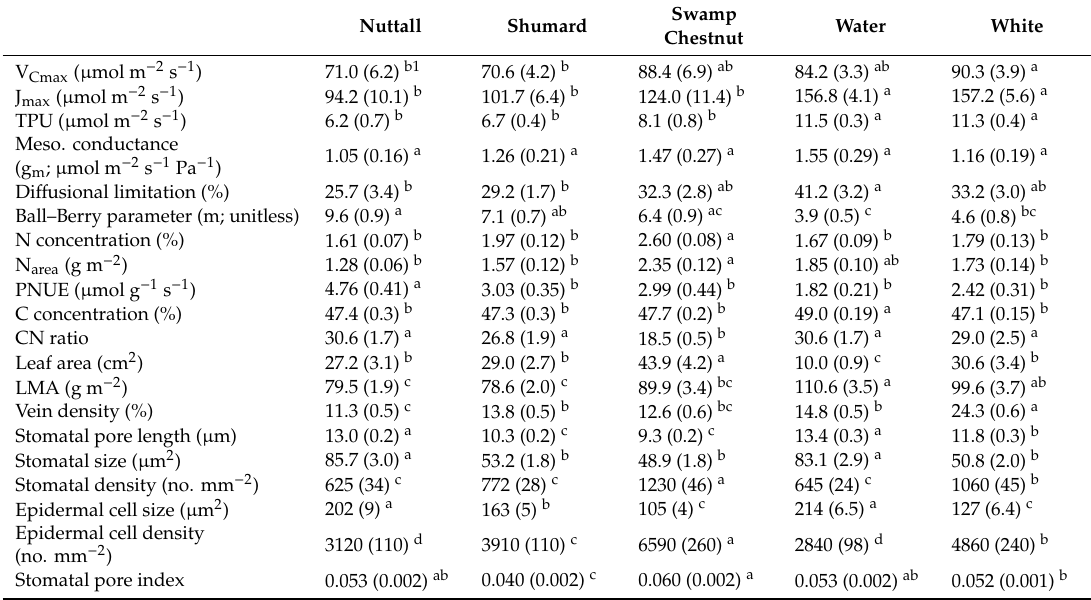
Table 2. Mean and standard error (in parentheses) of anatomic and physiological parameters for Nuttall, Shumard, swamp chestnut, water, and white oak planted on the Gulf coastal plain. Swamp Water White Nuttall Shumard Chestnut